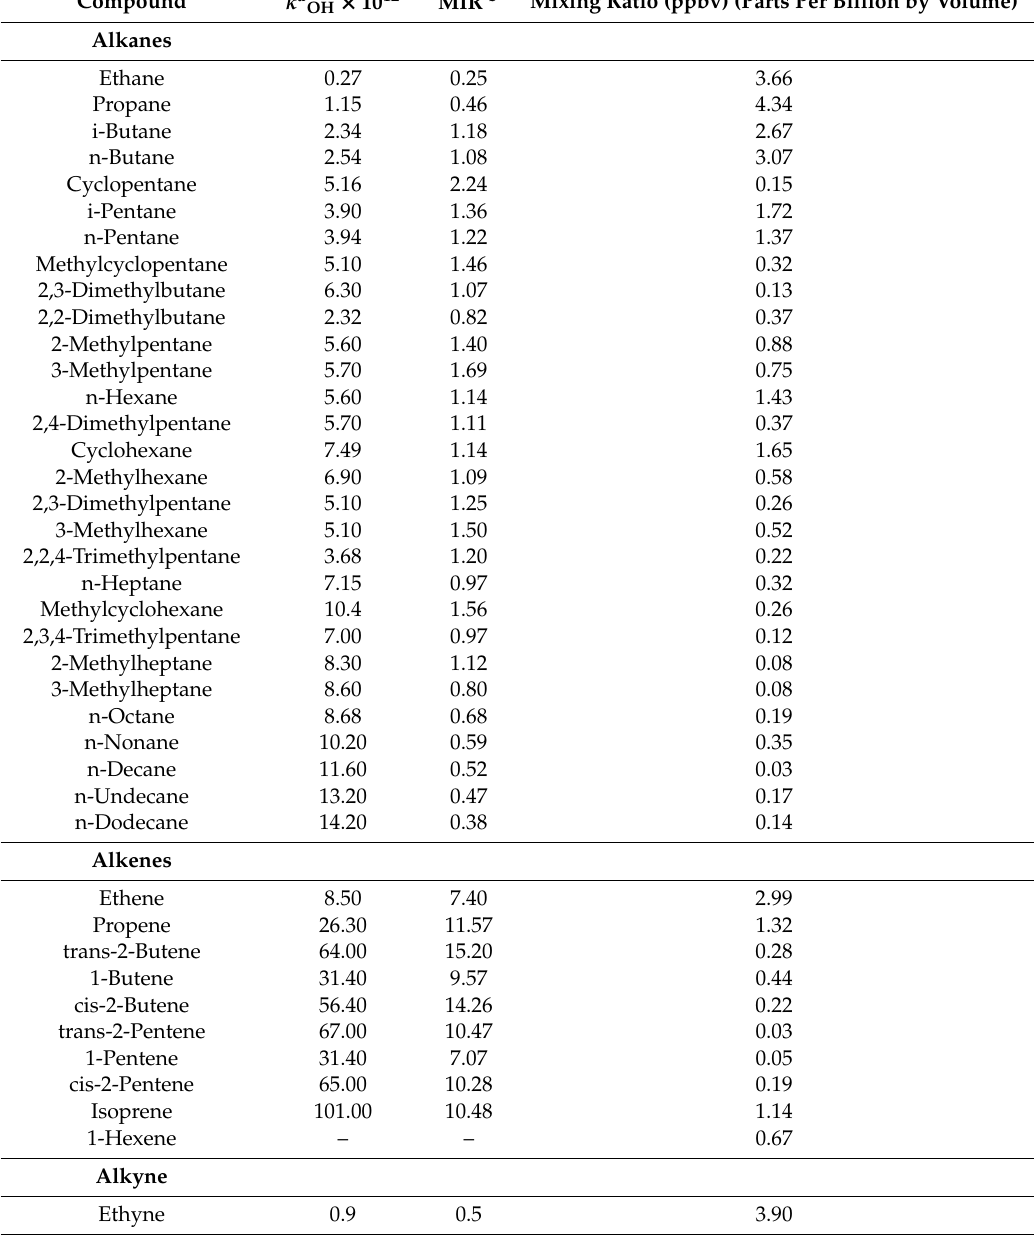
Table 2. The NMHCs’ OH (hydroxyl radicals of non–methane hydrocarbons) reaction rate constants, estimated MIR (maximum incremental reactivity) coe ffi cients, and their hourly mean mixing ratios